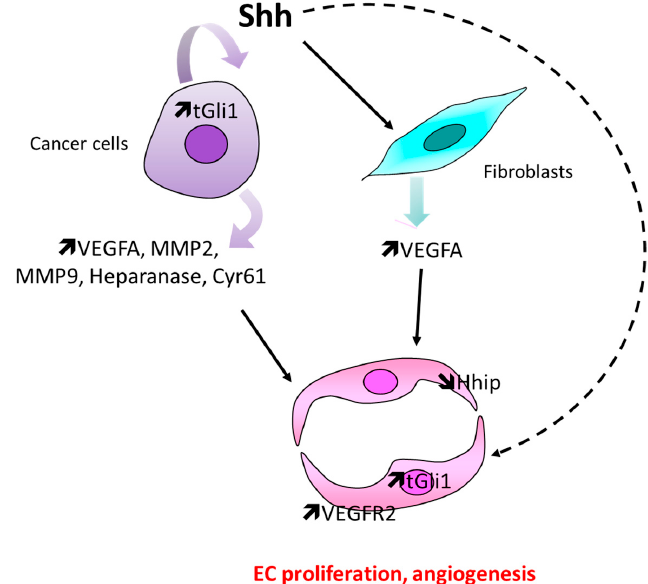
Figure 6. Schema representing the main cellular events involved in Hh-induced tumor angiogenesis. In tumors, Shh, which is mainly produced by cancer cells, may promote angiogenesis either by increasing proangiogenic factor expression in cancer cells themselves, by promoting Vegfa expression in stromal fibroblast, or by promoting EC proliferation directly through Gli1